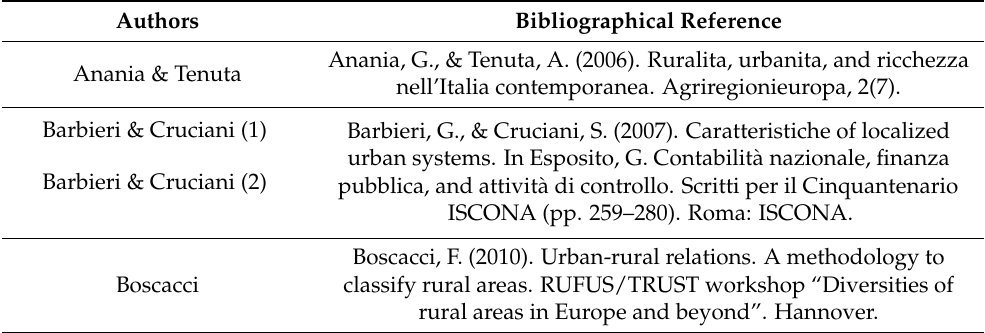
Table 1. The method considered in the present investigation, based on Cattivelli